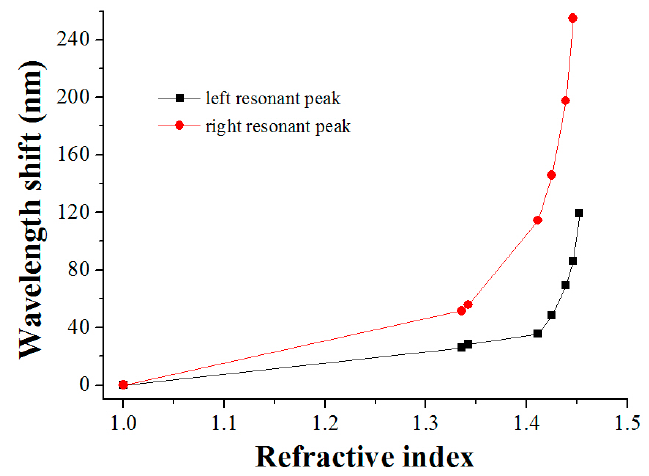
Figure 5. The wavelength changes of the two resonant peaks in the transmission spectra of the LPFG with the increase in RI.